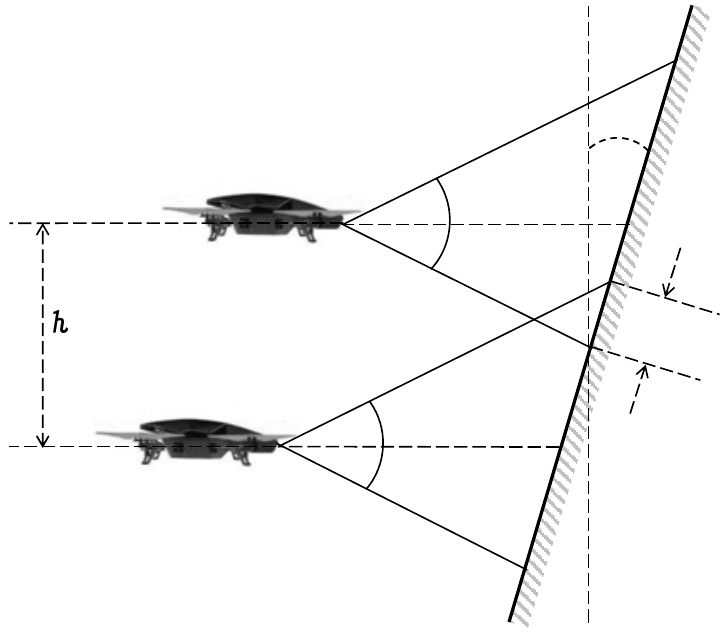
Figure 4. Vertical distance h between consecutive horizontal scans.